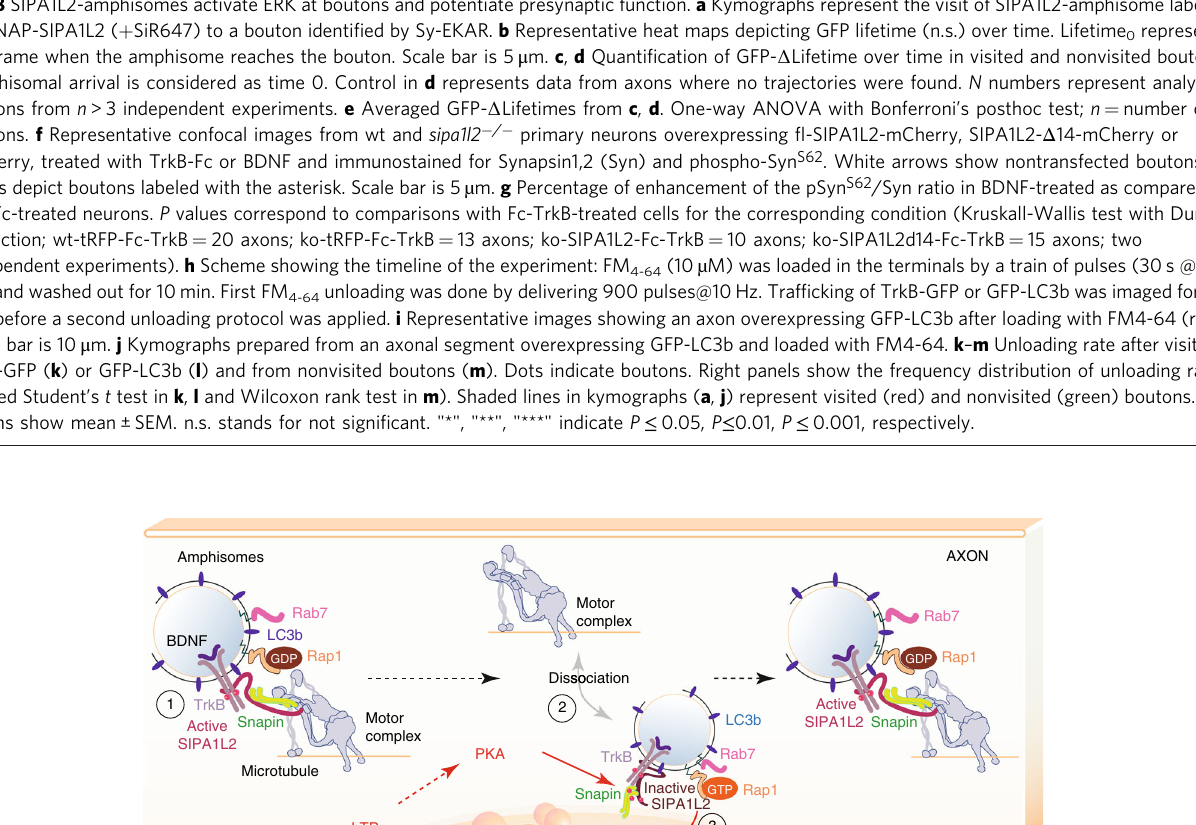
Fig. 8 SIPA1L2-amphisomes activate ERK at boutons and potentiate presynaptic function. a Kymographs represent the visit of SIPA1L2-amphisome labeled by SNAP-SIPA1L2 ( + SiR647) to a bouton identi fi ed by Sy-EKAR. b Representative heat maps depicting GFP lifetime (n.s.) over time. Lifetime 0 represents the frame when the amphisome reaches the bouton. Scale bar is 5 μ m. c , d Quanti fi cation of GFP- Δ Lifetime over time in visited and nonvisited boutons. Amphisomal arrival is considered as time 0. Control in d represents data from axons where no trajectories were found. N numbers represent analyzed boutons from n > 3 independent experiments. e Averaged GFP- Δ Lifetimes from c , d . One-way ANOVA with Bonferroni ’ s posthoc test; n = number of boutons. f Representative confocal images from wt and sipa1l2 − / − primary neurons overexpressing fl -SIPA1L2-mCherry, SIPA1L2- Δ 14-mCherry or mCherry, treated with TrkB-Fc or BDNF and immunostained for Synapsin1,2 (Syn) and phospho-Syn S62 . White arrows show nontransfected boutons. Insets depict boutons labeled with the asterisk. Scale bar is 5 µ m. g Percentage of enhancement of the pSyn S62 /Syn ratio in BDNF-treated as compared to Trk-Fc-treated neurons. P values correspond to comparisons with Fc-TrkB-treated cells for the corresponding condition (Kruskall-Wallis test with Dunn ’ s correction; wt-tRFP-Fc-TrkB = 20 axons; ko-tRFP-Fc-TrkB = 13 axons; ko-SIPA1L2-Fc-TrkB = 10 axons; ko-SIPA1L2d14-Fc-TrkB = 15 axons;